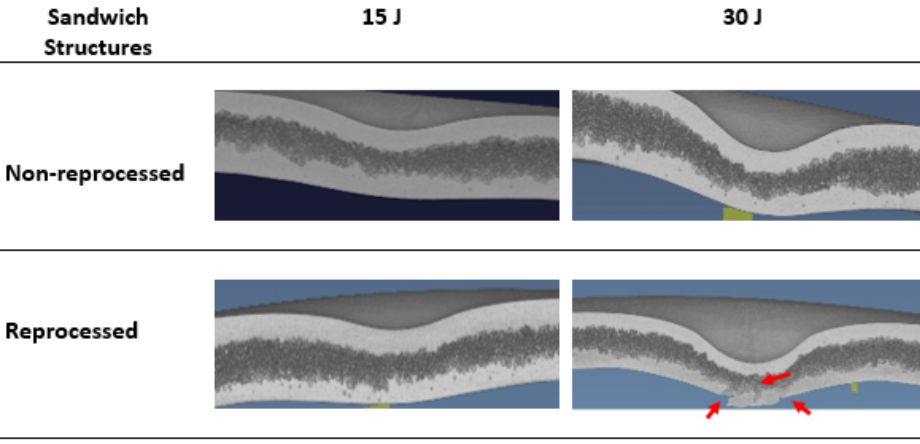
Figure 5. Section views of the X-ray damage images taken at the middle of the damage area of impacted non-reprocessed and reprocessed sandwich specimens at 15 J and 30 J impact energy levels. Red arrow marks indicate the cracks.